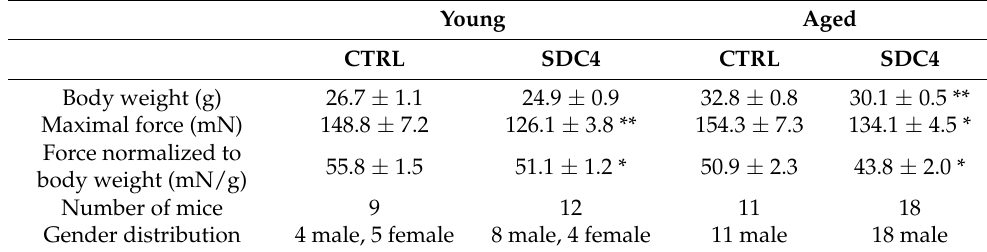
Table 1. Forepaw grip force measurement.